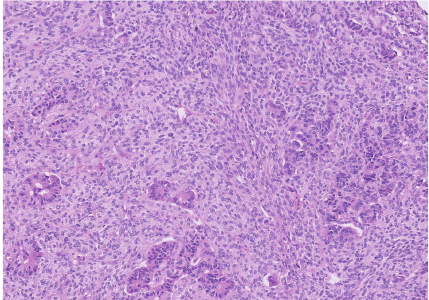
Figure2:Malignantpoorlyformedepithelialglandswithsurround- ing malignant spindle cell sarcoma (H&E × 10 objective).